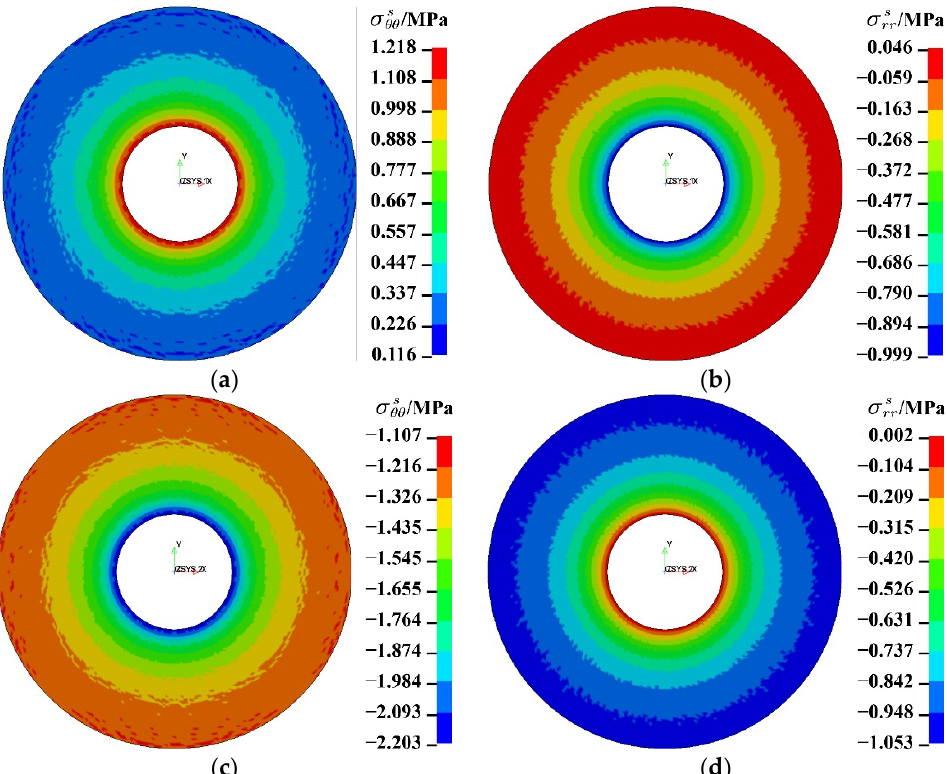
Figure 7. Distribution of circumferential and radial stresses due to static loading. Case 1: ( a ) circumferential stress, P h = 1 MPa, P c = 0 MPa; ( b ) radial stress, P h = 1 MPa, P c = 0 MPa. Case 2: ( c ) circumferential stress, P h = 0 MPa, P c = 1 MPa; ( d ) radial stress, P h = 0 MPa, P c = 1 MPa.